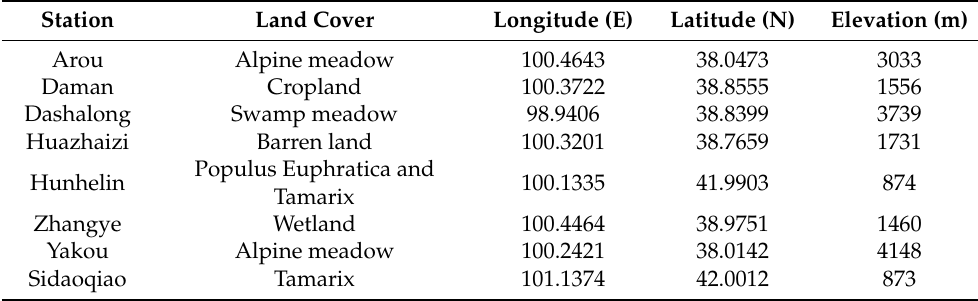
Table 1. Site location and underlying surface information of Heihe River